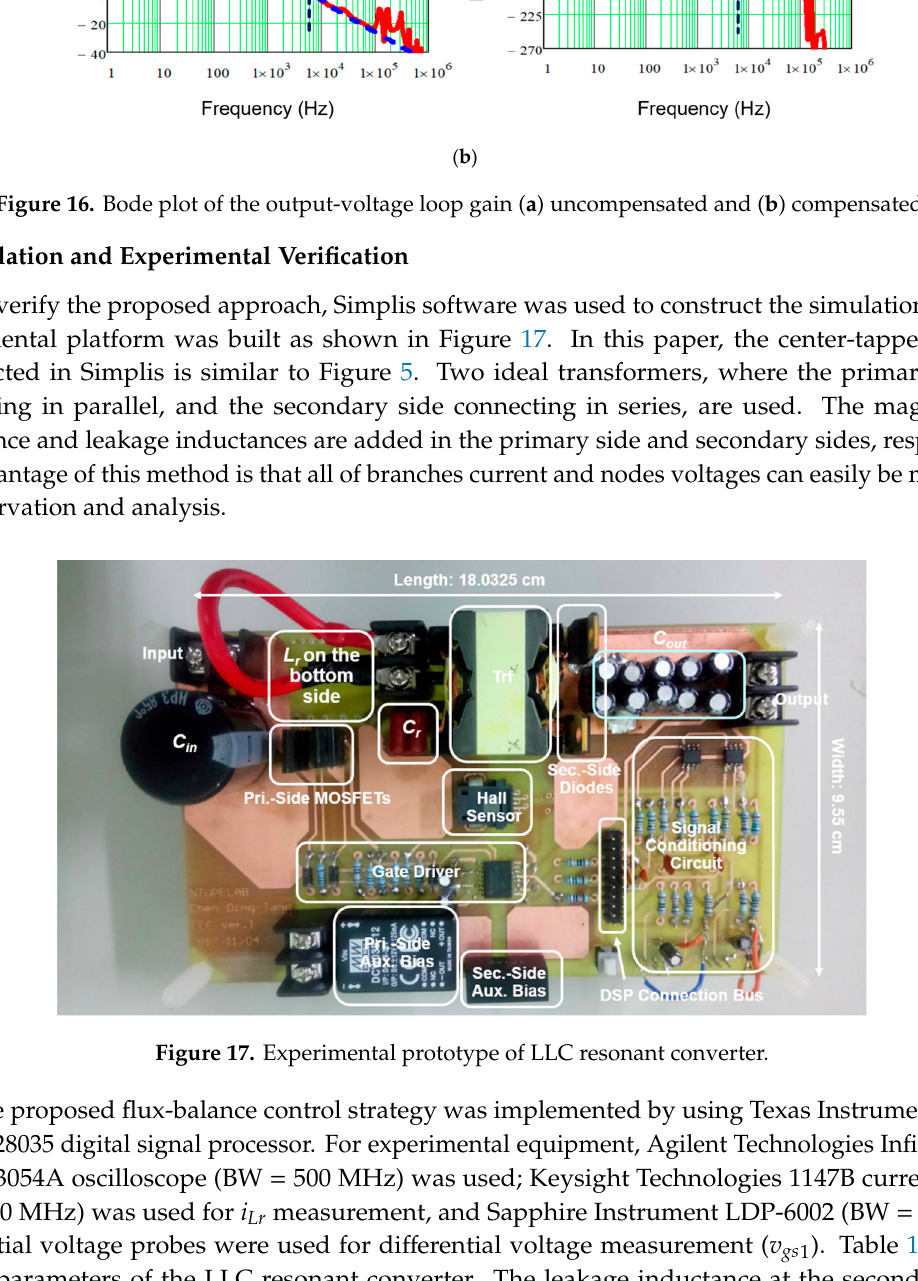
Figure 17. Experimental prototype of LLC resonant converter.